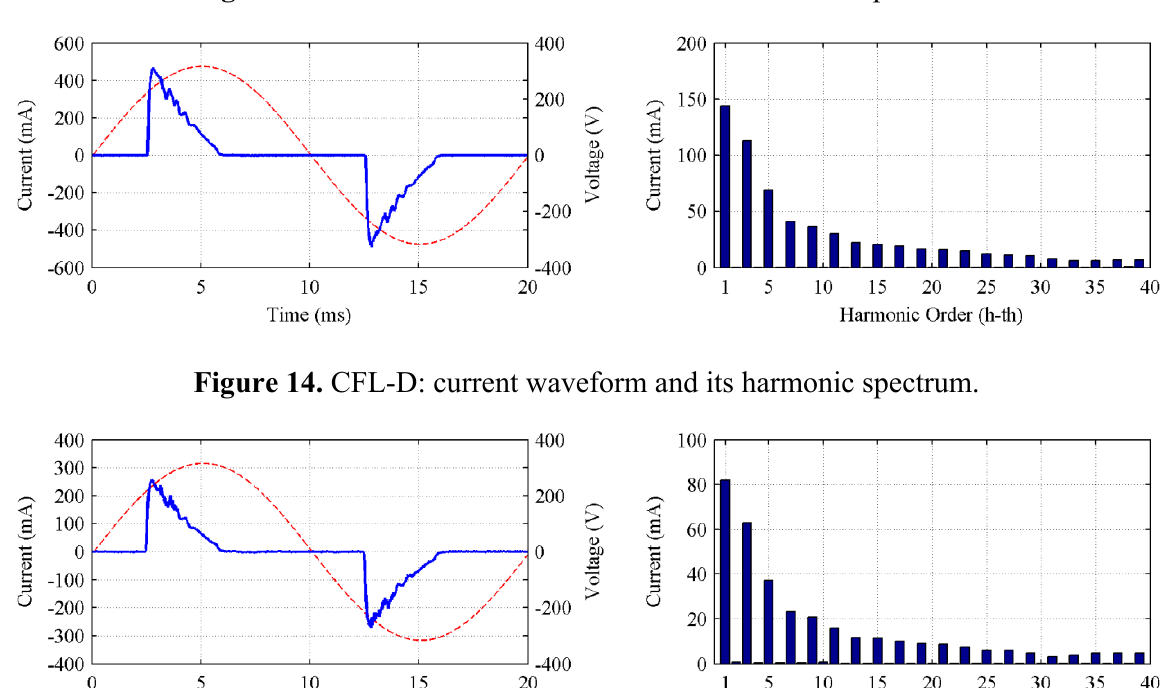
Figure 13. CFL-C: current waveform and its harmonic spectrum.